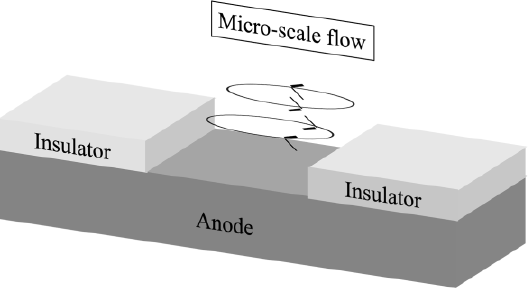
Figure 5. Liquid flow pattern under DC + MF condition from 5 s to 20 s in y -range of 120 μm to 280 μm .